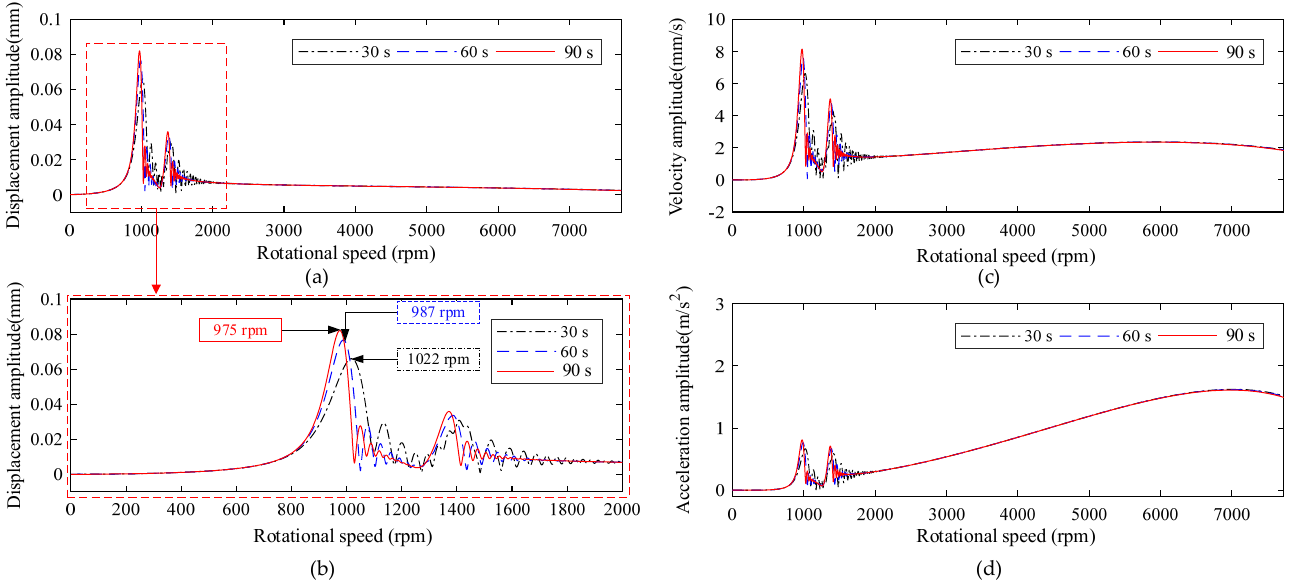
Figure 16. Dynamic response of investigated point A (node 51) of different acceleration speed-up times. ( a ) Displacement amplitude curve; ( b ) local enlarged drawing of Figure 16a; ( c ) velocity amplitude curve; ( d ) acceleration amplitude curve.